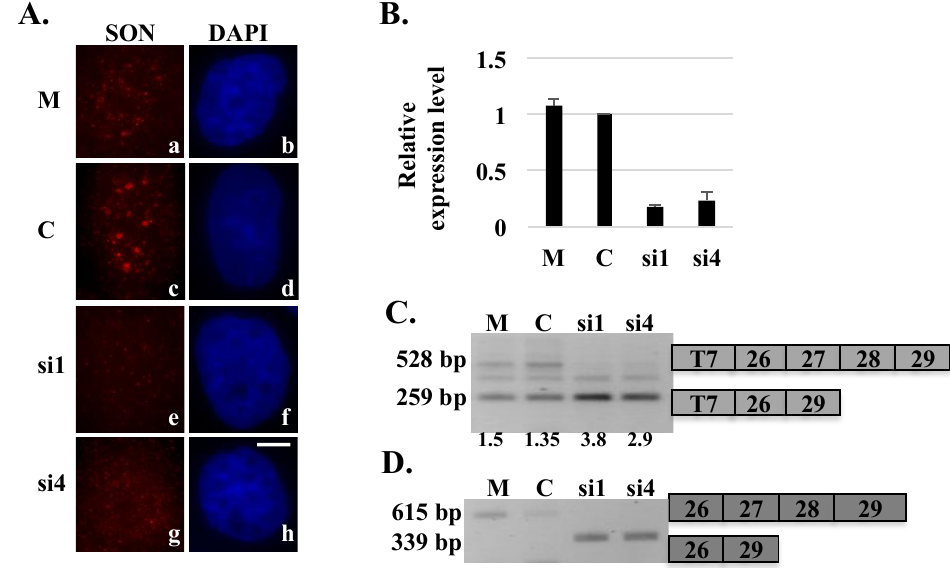
Figure 3. Stably expressed HDAC6 reporter transcripts show exon skipping after SON depletion. HeLa HDAC6 clone 69 stably expressing HDAC6 reporter plasmid was transfected with mock (M), control (C) or SON siRNA duplexes and processed for either immunofluorescence ( A ) or harvested to perform qRT-PCR ( B ) to show SON depletion. Cells treated with SON siRNA and immunolabeled with anti-SON antibodies in ( A ) do not show SON labeling in nuclear speckles ( e and g ) when compared to mock ( a ) or control siRNA ( c ) treated cells. DNA was stained with DAPI ( b , d , f and h ). Scale bar = 5 µm. qRT-PCR in ( B ) showed reduction of SON mRNA levels in SON siRNA-treated